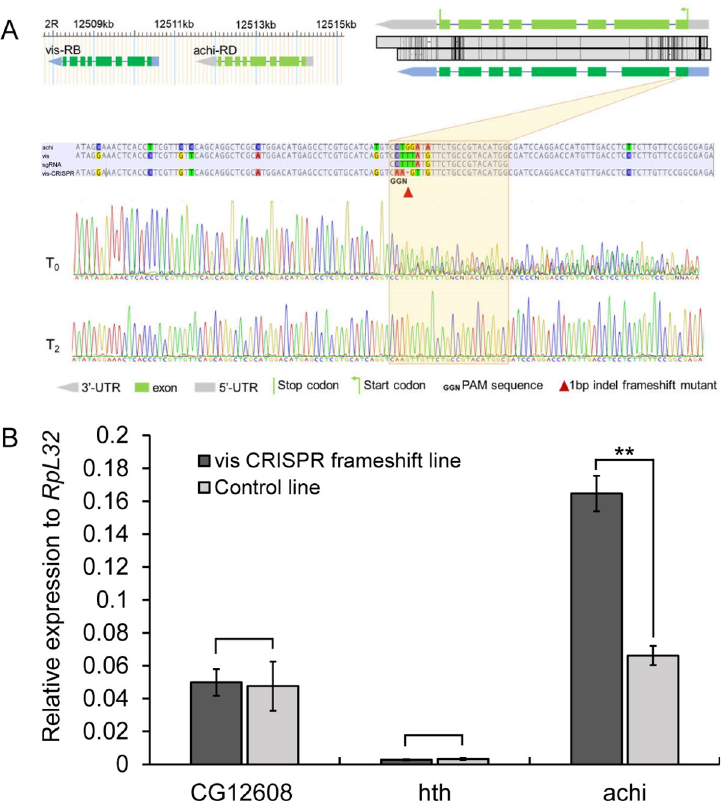
Fig 6. CRISPR/Cas9 frameshift mutant could induce compensatory effect in Drosophila . A. Design of CRISPR/ Cas9 mutant. We targeted a randomly chosen young gene, vis , which emerged via duplication of achi in the common ancestor of melanogaster species complex. The genomic arrangement of two genes are shown in the upper left panel with the boxes referring to exons and connecting lines as introns. The pair shares a high sequence identity (0.92) in their 9 exons, which is schematically shown in the upper right panel. The middle panel shows the diverged site between vis and achi , which was chosen to design a short guide RNA (sgRNA) specifically targeting vis . The mutation (CTTTA ! AAGT) was marked with a red triangle. The raw sanger sequencing data for the initial generation (T0) and the second generation of offspring (T2) was shown. B. The compensation effect of achi . In the frameshift mutant of vis , achi ’s expression is significantly increased (P = 0.0003). By contrast, the unrelated CG12608 and the remotely related hth did not show any significant upregulation. RpL32 was used as a control as in